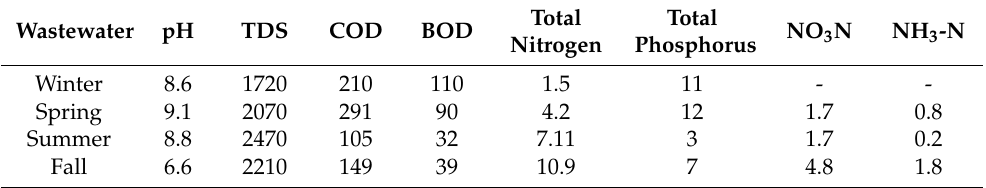
Table 1. Physicochemical properties of the wastewater calculated in mgL − 1 during different